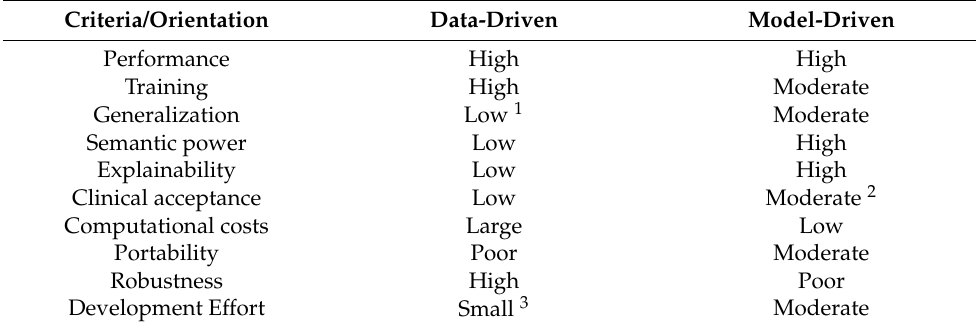
Table 1. Comparison of DD vs. MD approaches. Observations: 1 If contaminated by training data (see [8]). 2 Assuming that results meet specific clinical criteria. 3 When using transfer learning (TL) with little adaptation